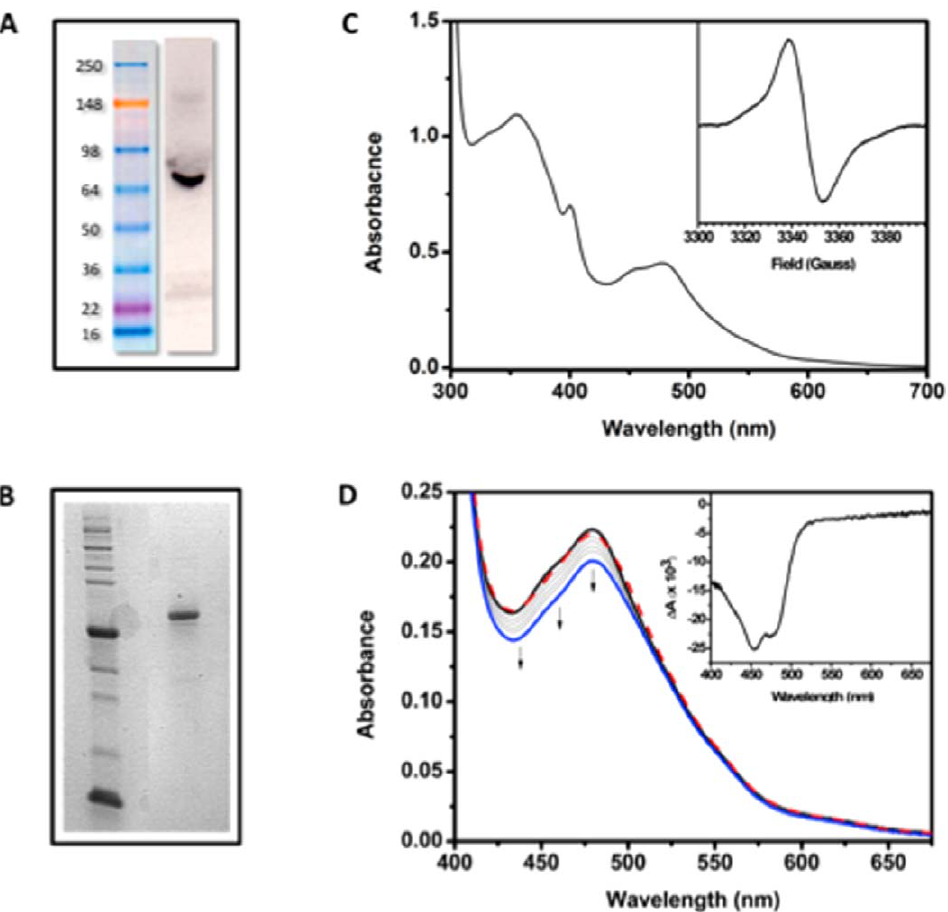
Figure 5. Purification and characterization of HsCRY1. A. Western blot confirming the expression of HsCRY1 using the Homo sapiens CRY1 polyclonal rabbit antibody. B. Coomassie-stained SDS PAGE of purified HsCRY1 (66 kDa). C. UV-visible spectrum of purified HsCRY1. Inset: Averaged cwEPR spectrum of a , 290 m M sample of HsCRY1. The peak-to-peak linewidth is 15.4 G at a g-value of 2.0042, which indicates an anionic semiquinone. D. UV-visible absorbance spectra representing the photoreduction of HsCRY1 in the presence of 20 mM DTT. The sample was exposed to 100 m mol m 2 2 s 2 1 of 440–460 nm light for a maximum of 85 minutes. Black line - before irradiation; blue line - after 85 min irradiation; red, dashed line – reoxidation in dark (within , 2 min). Inset: the difference spectrum (Light minus dark) showing peak reduction at 450 nm consistent with oxidized flavin.